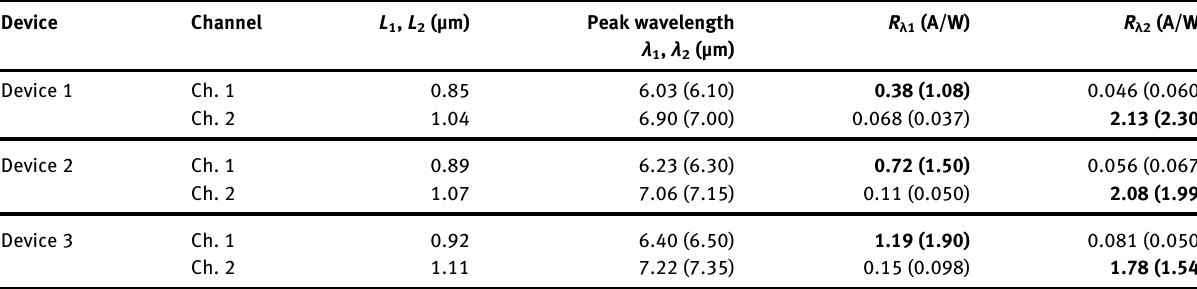
Table  : Peak wavelengths and corresponding resonant (bolded) and non-resonant responsivity values of quantum well infrared photodetector (QWIP) stripes in different dual-band